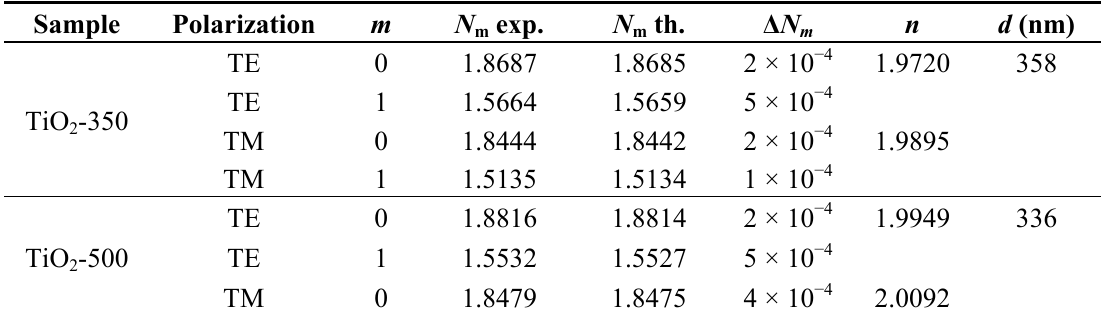
Table 1. Measured ( N thicknesses deduced from these